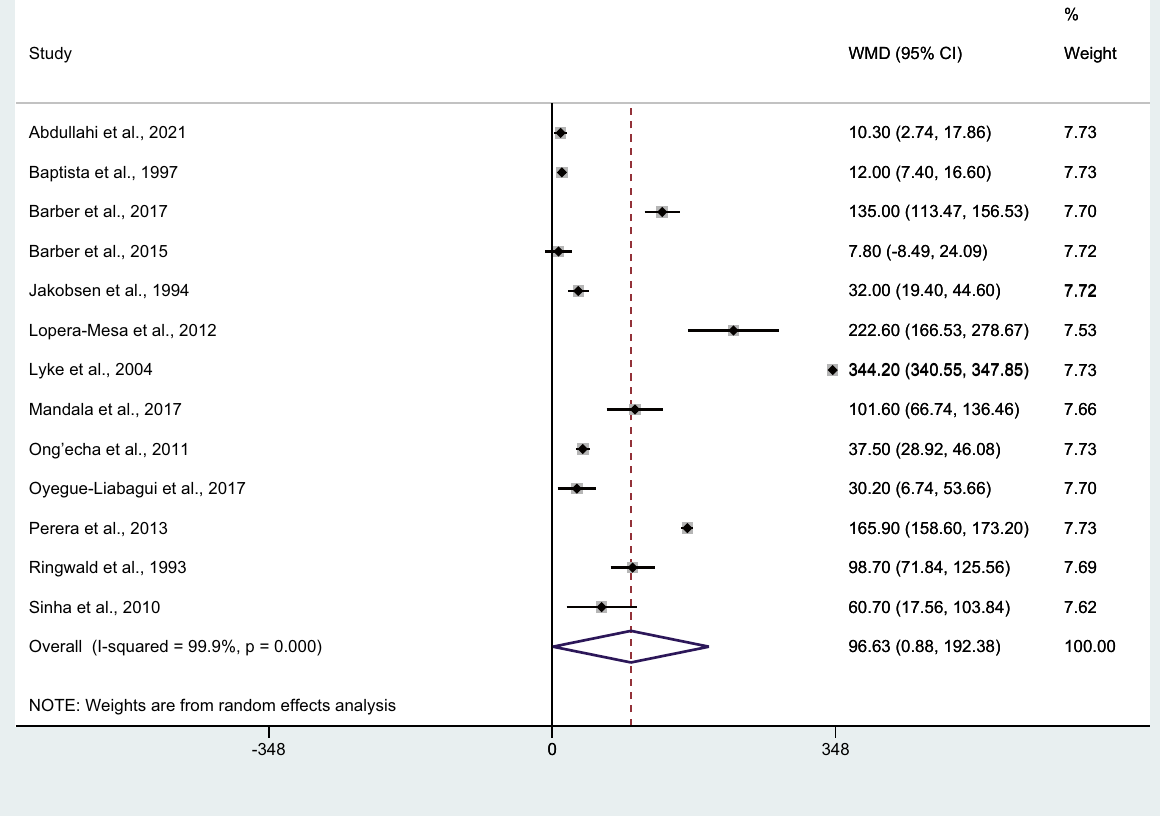
Fig. 7). Meta-regression analyses of continents, Plasmodium species, parasitemia, age groups, male percentage, characteristics of the control groups, and IL-6 measurement methods showed that these co-variates did not confound the effect estimate ( P > 0.05). Subgroup analysis of continents showed that the mean IL-6 levels were higher in patients with uncom- plicated malaria than in controls among studies conducted in Africa ( P = 0.028, WMD = 41.68 pg/ mL, 95% CI = 4.45–78.91 pg/mL, I 2 = 100%, 11 studies) and Asia ( P = 0.003, WMD = 75.04 pg/mL, 95% CI = 24.97−125.11 pg/mL, I 2 = 99.7%, two studies). No differences in IL-6 levels between patients with uncom- plicated malaria and controls were observed among studies conducted in America ( P = 0.403, WMD = 2.41 pg/ mL, 95% CI = − 3.24 –8.07 pg/mL, I 2 = 97.9%, three studies; Fig. 8). Subgroup analysis of Plasmodium species showed higher mean IL-6 levels in patients with uncomplicated malaria than in controls among studies that enrolled patients infected with only P. falciparum ( P = 0.008, WMD = 43.86 pg/mL, 95% CI = 11.52–76.2 pg/mL, I 2 = 100%, 13 studies). No differences in IL-6 levels were observed between patients with uncomplicated malaria and controls among studies that enrolled patients infected with P. falciparum/P. vivax ( P = 0.319, WMD = 199.6 pg/mL, 95% CI = − 193.13 –592.3 pg/mL, I 2 = 98.7%, two studies; Fig. 4) or only P. vivax ( P = 0.32, WMD = 25.57 pg/mL, 95% CI = − 24.8 −75.9 pg/mL, I 2 = 100%, two studies; Fig. 9). Subgroup analysis of age groups showed higher mean IL-6 levels in people with uncomplicated malaria than in controls among studies that enrolled patients of all age groups ( P < 0.001, WMD = 43.47 pg/mL, 95% CI = 27.63 − 59.31 pg/mL, I 2 = 95.7%, two studies) or adults only ( P < 0.001, WMD = 22.97 pg/mL, 95% CI = 12.03–33.9 pg/mL, I 2 = 99.9%, eight studies). No differences in IL-6 levels were observed between patients with uncomplicated malaria and controls among studies that enrolled only children ( P = 0.189, WMD = 53.72 pg/ mL, 95% CI = − 26.47–133.91 pg/mL, I 2 = 100%, seven studies, Fig. 10). Subgroup analysis of assays used to measure IL-6 showed higher mean IL-6 levels in those with uncomplicated malaria than in controls among studies using an ELISA for IL-6 measurement ( P = 0.008, WMD = 39.65 pg/mL,